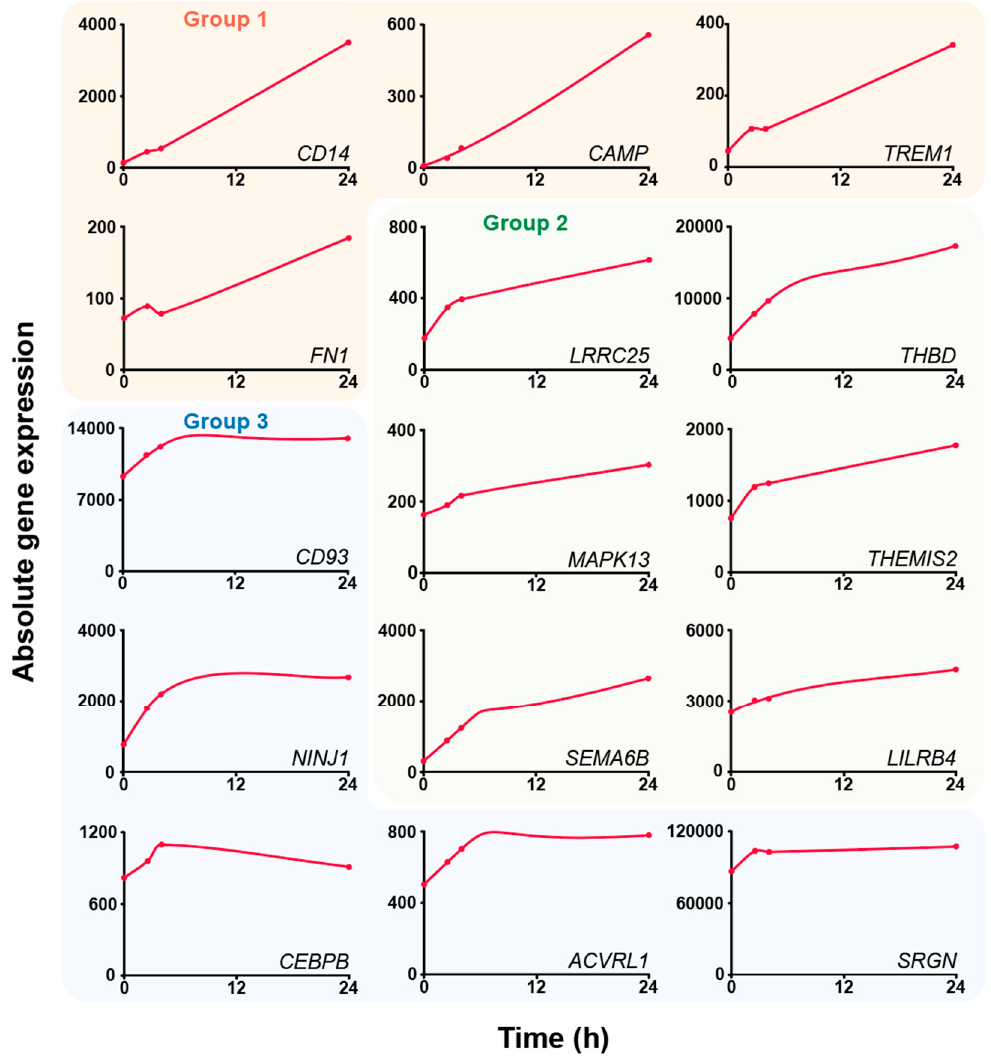
Figure 4. Dynamic response of gene expression to 1,25(OH) 2 D 3 . Based on published RNA-seq data from THP-1 cells [29], the increase in expression after 1,25(OH) 2 D 3 stimulation of the 15 key genes is displayed for basal activity (solvent control) and the time points 2.5, 4 and 24 h. Genes are classified into three groups based on the steepness of the expression curves. Table 2. Transcriptomic profile of key immune-related vitamin D target genes in THP-1 cells. Based on published RNA-seq data of a time course (2.5, 4 and 24 h) of 1,25(OH) 2 D 3 stimulation in THP-1 cells [29], the 15 key genes were categorized as primary or secondary vitamin D targets and into tertials (top, mid and low) with respect to their basal activity (expression level with solvent control), their inducibility (fold change at 24 h) and sensitivity ( p -value at 24 h). The classification of the genes is based on the steepness of the dynamic response of gene expression to 1,25(OH) 2 D 3 stimulation (Figure 4).